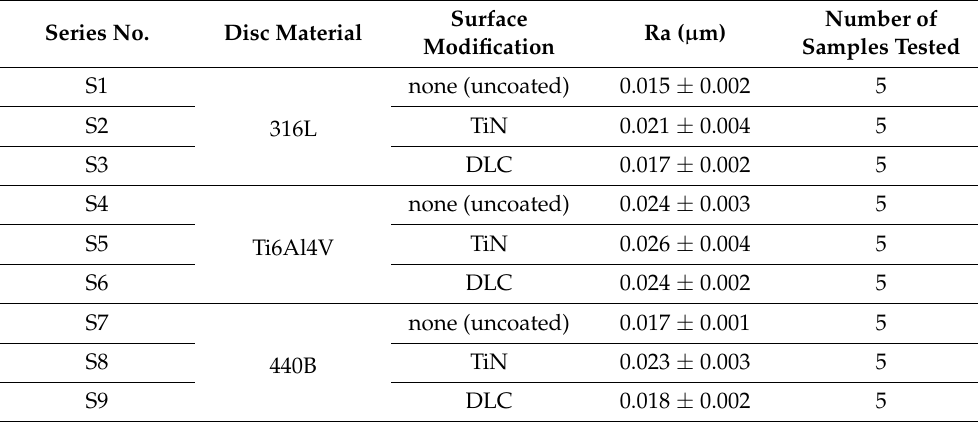
Figure 2. A schematic representation of the ball on disc configuration used during the sliding wear tests. Table 5. Summary of all samples tested. The number of Ra measurement replications in each series was equal to